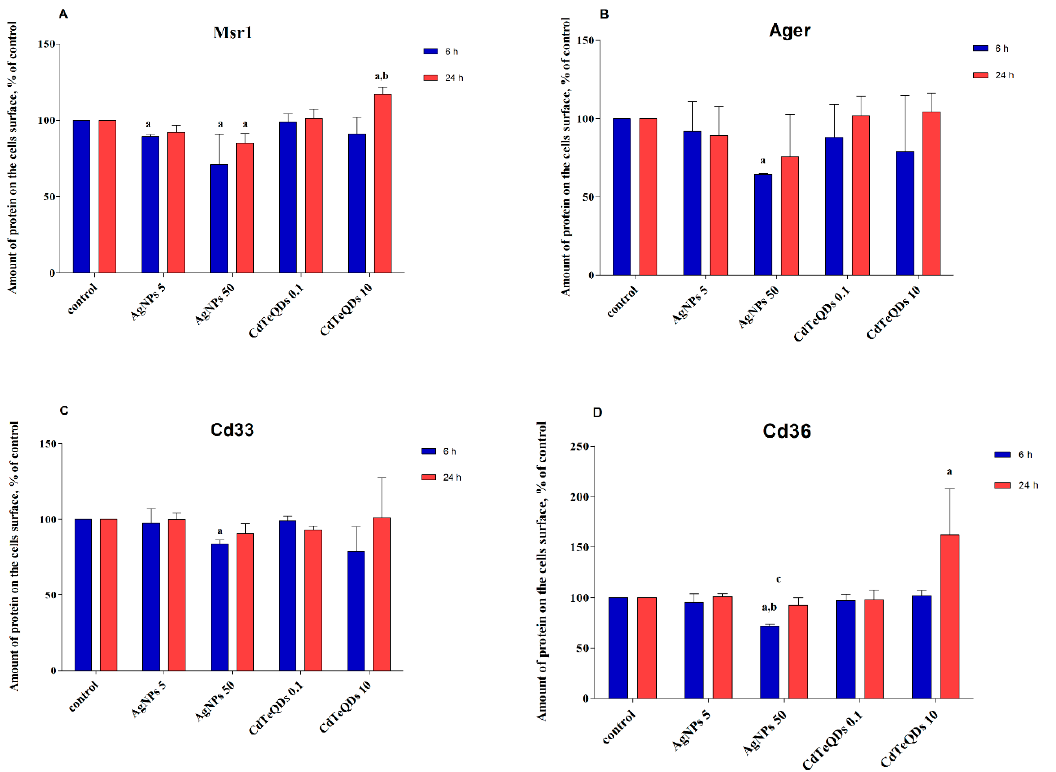
Figure 7. The abundance of Msr1 ( A ), Ager ( B ), Cd33 ( C )or Cd36 ( D ) receptors on the BV ‐ 2 cells surface by flow cytometry. The cells were treated with CdTeQDs (0.1 or 10 µg mL − 1 ) or AgNPs (5 or 50 µg mL − 1 ) for 6 or 24 h. Mean ± SD, n = 3. ‘a’ denotes statistically significant difference from unexposed control, ‘b’ denotes statistically significant difference between low and high concentration of NPs, ‘c’ denotes statistically significant difference between 6 and 24 h treatment, two ‐ way ANOVA, post ‐ hoc Tukey's test, P <